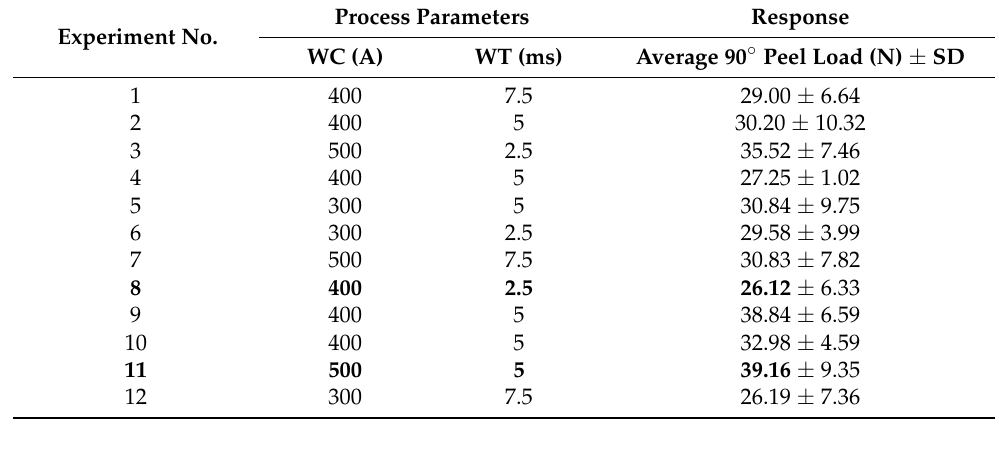
Table 3. Experimental design and measured response. Experiment No.